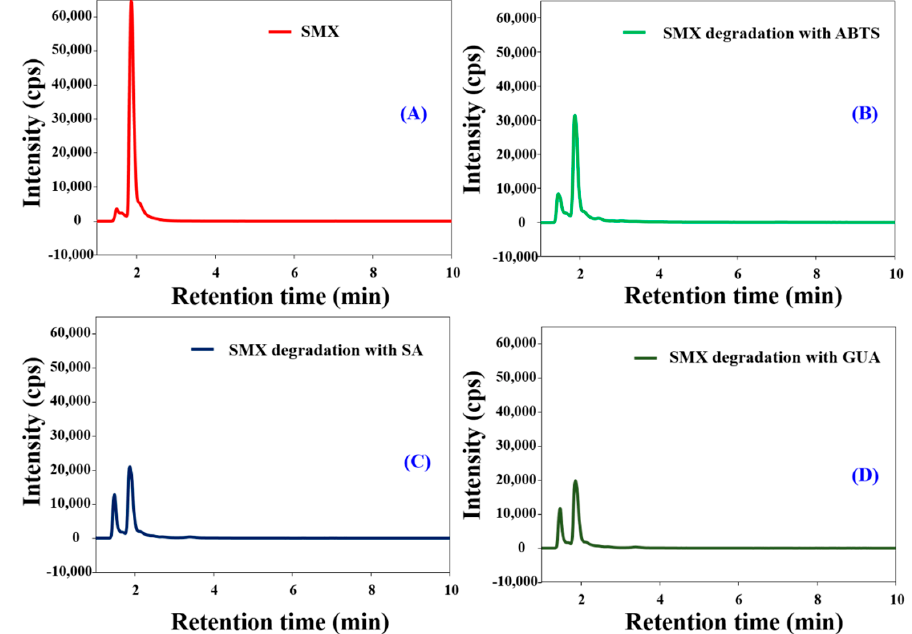
Figure 9. The high-performance liquid chromatography (HPLC) analysis of ( A ) sulfamethoxazole (SMX), ( B ) HNTs-M-chitosan (1%)-GTA- Laccase catalyzed SMX degradation with ABTS; ( C ) HNTs-M-chitosan (1%)-GTA- Laccase catalyzed SMX degradation with syringaldehyde (SA) and ( D ) HNTs-M-chitosan (1%)-GTA- Laccase catalyzed SMX degradation with guaiacol (GUA).